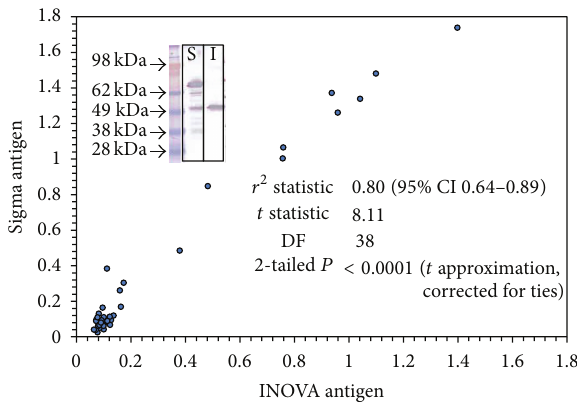
Figure 1: Comparison of two different antigens for the detection of anti-HMGCRantibodiesusingwesternblotandELISA.Thewestern blot shows the staining of a serum with anti-HMGCR antibodies of INOVA (I) and Sigma (S) antigen. A total of 40 samples with or without anti-HMGCR antibodies were compared by ELISA and the Spearman correlation shows good correlation between the two